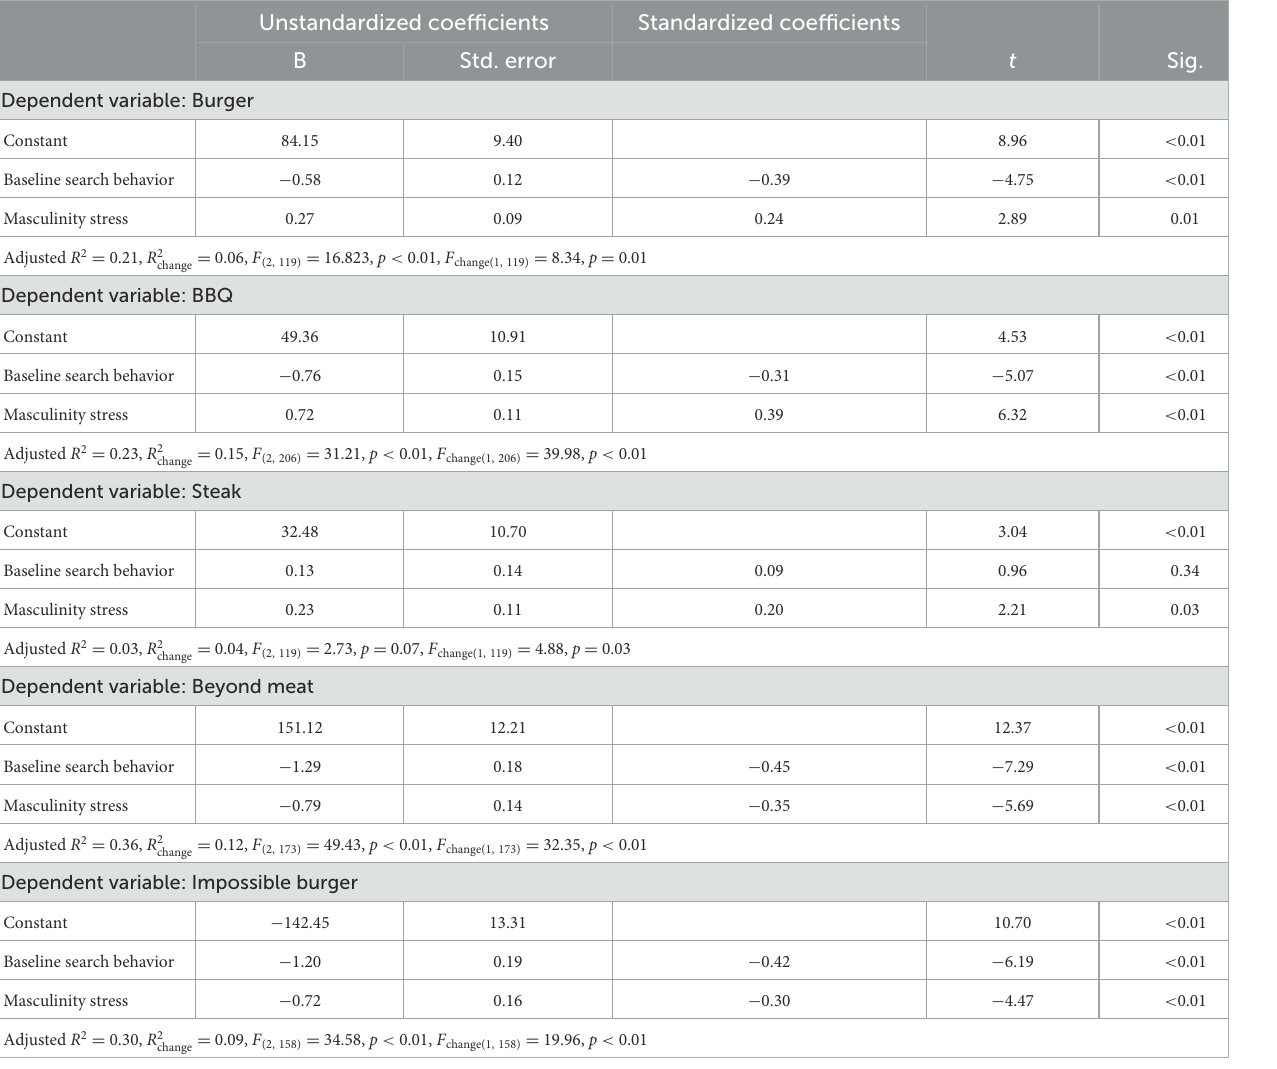
TABLE 2 Study 1: Full regression results for full model with both independent variables added. Unstandardized coefficients Standardized